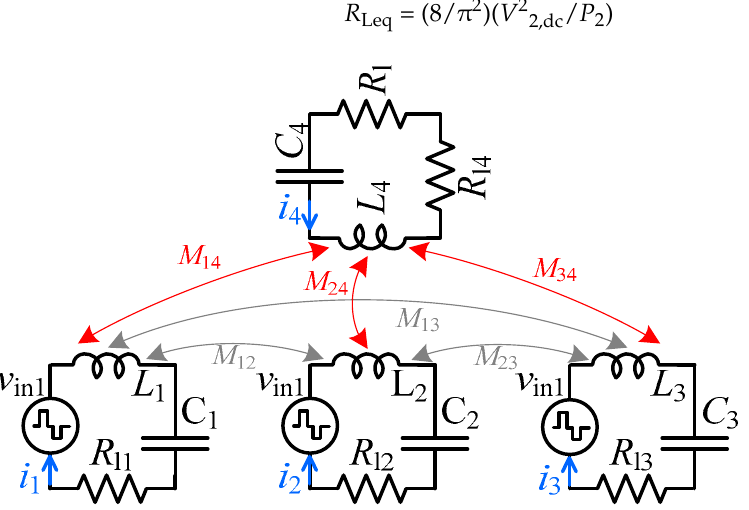
Figure 5. Simplified model of the multicoil transmitter solution.